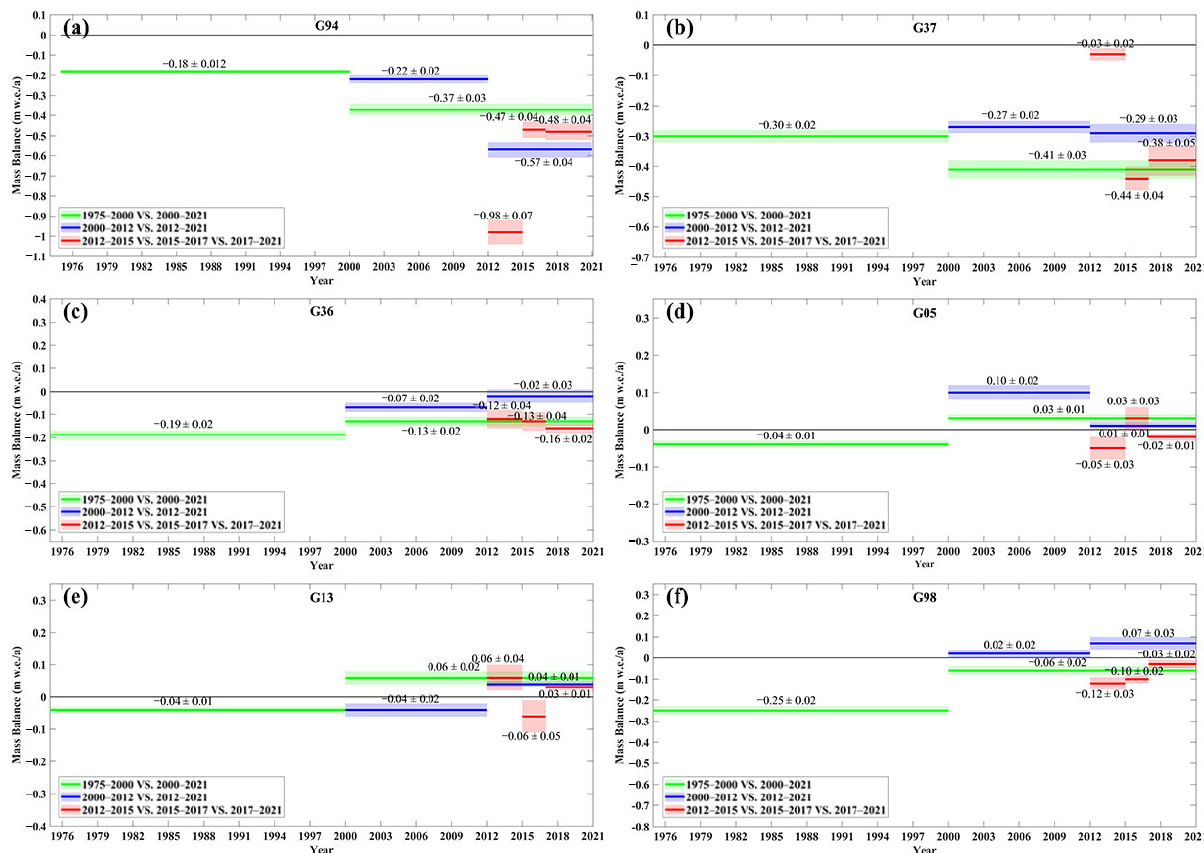
Figure 10. Comparisons of the mass balance of six selected glaciers over different periods: ( a ) the G94 glacier; ( b ) the G36 glacier; ( c ) the G37 glacier; ( d ) the G05 glacier; ( e ) the G13 glacier; ( f ) the G98 glacier.